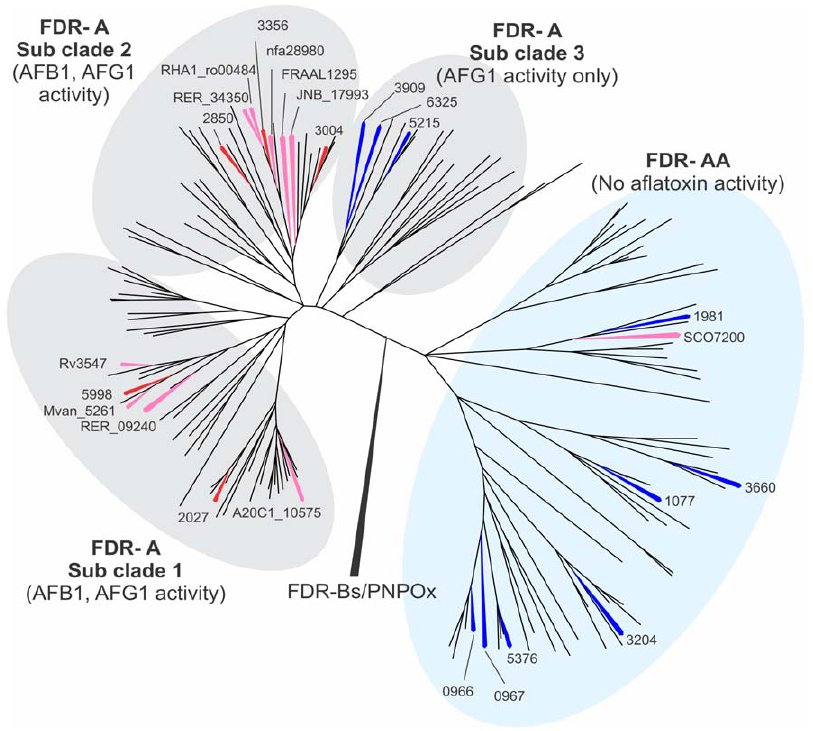
Figure 1. Phylogeny of 164 FDR-A enzymes from 20 Actinomycetales genomes. Phylogenetic methods and the genomes used are given in the Materials and Methods. For clarity, only the FDR-As that have been characterized biochemically are labeled ( M. smegmatis previously characterized (red), M. smegmatis characterized herein (blue) and the other Actinomycetales species characterized herein (pink)). The M. smegmatis enzymes are labeled with their locus tag numbers (the MSMEG_ prefix being deleted for clarity) while the enzymes from the other species are labeled with their complete locus tag. All the characterized enzymes are also given simple number designations (in brackets) to aid comparison with later figures. A fully labeled version of this phylogeny is given as Figure